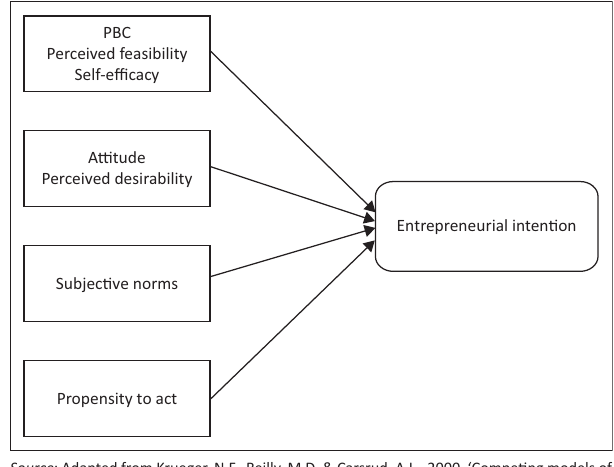
FIG URE 1: The theory of planned behaviour and Entrepreneurial Event Model influences on entrepreneurial intention and framework that